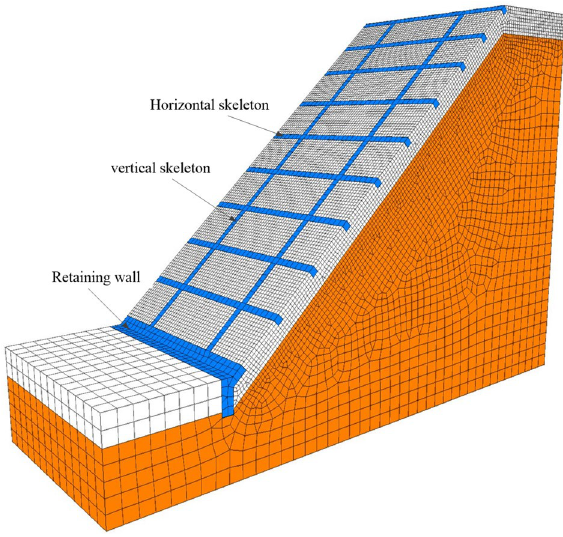
Figure 6. 3D view of the numerical model.